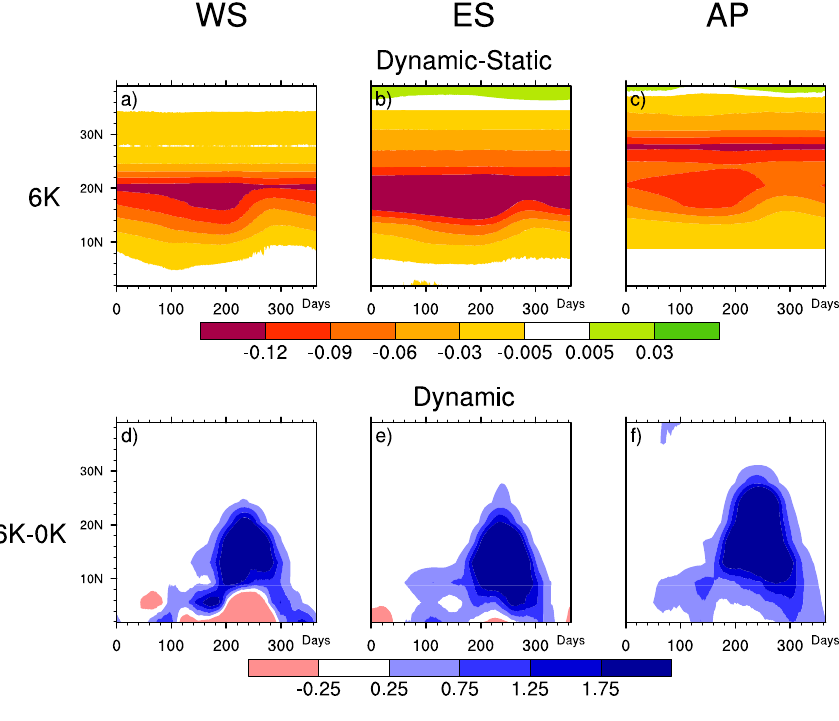
Fig. 7. Shown are differences in the annual cycle of precipitation and albedo derived from 100 simulation years. (a) to (c) show albedo differences between 6K dyn and 6K st, for regions WS, ES and AP. (d) to (f) show precipitation differences in mmday − 1 (further filtered by 30-day running means) between 6K dyn and 0K dyn, for regions WS, ES and